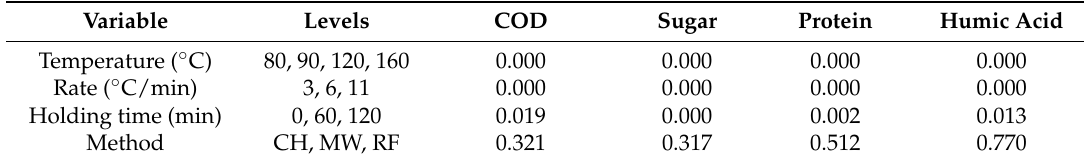
Table 1. Summary of the p -values obtained via an overall statistical analysis. Table 1 . Summary of the p -values obtained via an overall statistical analysis.